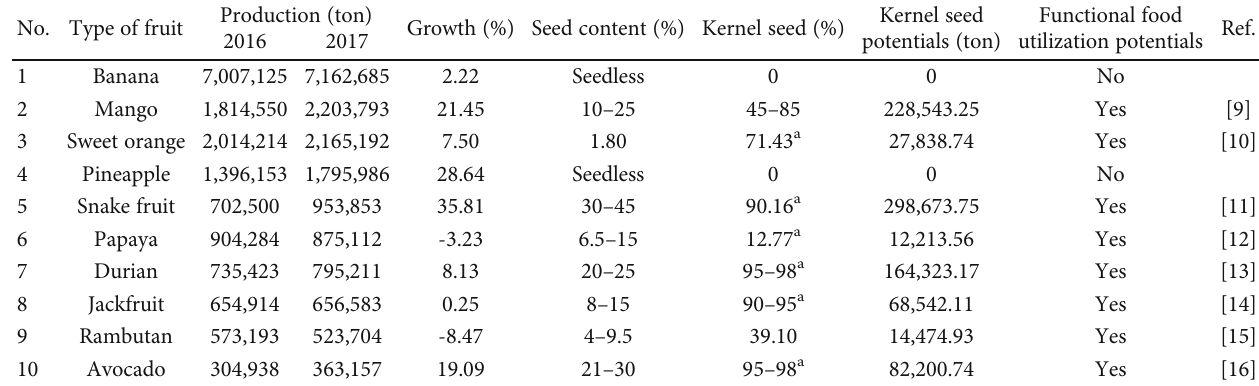
Table 1: The annual production of Indonesian exotic fruits in 2017